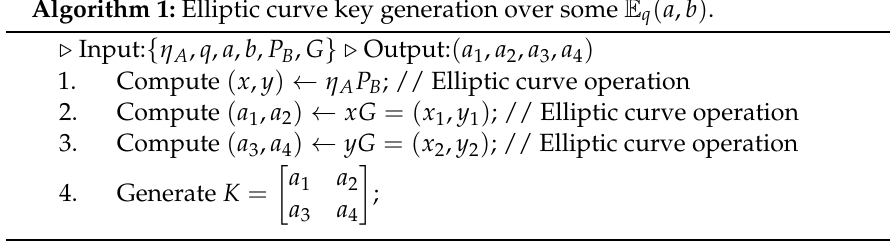
Algorithm 2: Encryption algorithm of the scheme